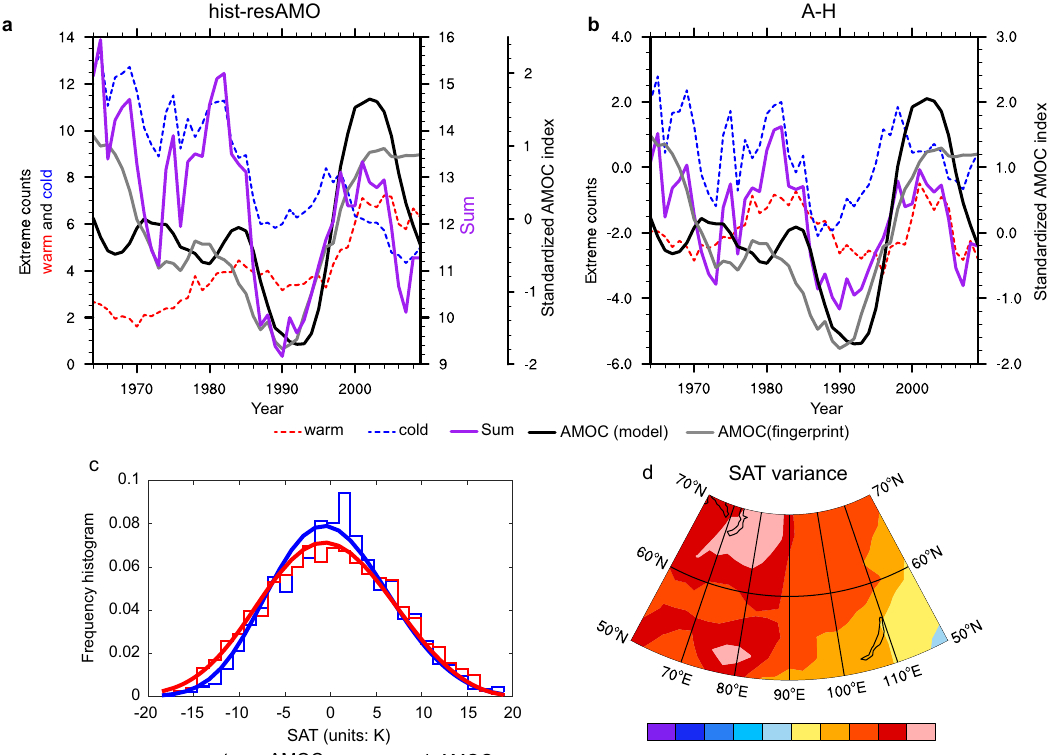
Fig. 3 AMOC effect on the winter SAT extremes over Siberia based on the model simulations. Decadal changes in the frequencies (day season − 1 ) of warm extremes (dashed red line), cold extremes (dashed blue line) and Sums (solid purple line) over Siberia in winter and the AMOC (so) index (solid black line) during 1960 – 2016 based on the multi-model means of the hist-resAMO experiment ( a ) and A-H experiment ( b ). The fi ngerprint AMOC index (solid grey line) is shown for comparison. The left y-axis is for warm and cold extremes, and the right two y-axes are for the Sum and AMOC index in ( a ). The left y-axis is for warm, cold extremes and Sum, and the right y-axis is for the AMOC index in ( b ). c Frequency histograms (staircase curves) and GEV fi ttings (smooth curves) of the winter SAT anomalies (unit: K) over Siberia during the weak AMOC phase (blue lines) and strong AMOC phase (red lines). d Differences in the variances (unit: K 2 ) of the winter SATs over Siberia between the strong and weak AMOC phases. c and d are based on the multi-model composite of the hist-resAMO